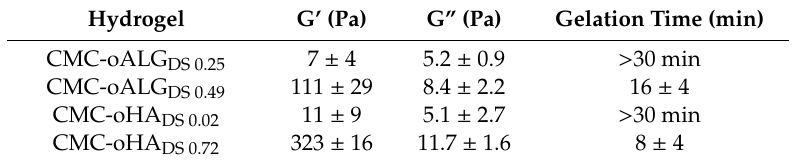
Figure 6. Rheological properties of the hydrogels at 37 °C. Each curve corresponds to the average of three different samples. ( A ) Crosslinking process represented with storage modulus as a function of reaction time at a frequency of 1 Hz and 0.1% strain. ( B ) Dependence of the complex modulus (G*) on the strain amplitude at a frequency of 1 Hz of the already crosslinked hydrogels, measured after the crosslinking process. ( C , D ) Evolution of the storage (G’) and loss (G”) moduli, respectively, as a function of the frequency at 0.1% stain of the crosslinked hydrogels. Table 3. Storage (G’) moduli, loss (G”) moduli, and gelation times of the